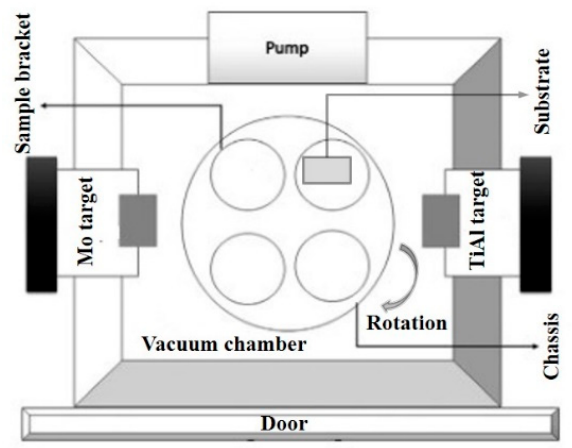
Figure 1. Experimental set-up (top view) for deposition of Mo-Ti-Al-N composite coatings, not to scale.